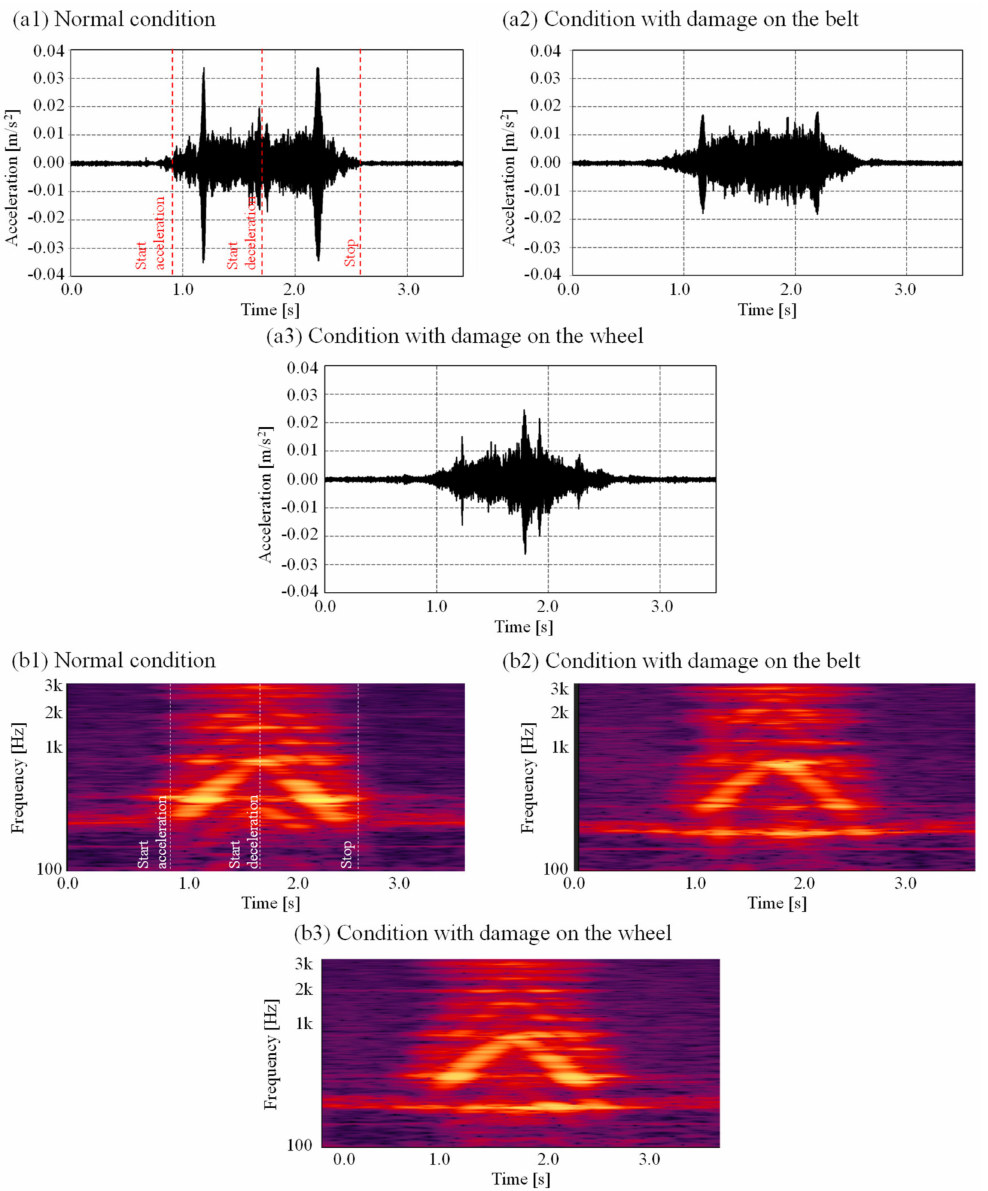
Figure 13. Acceleration waveforms and their spectrograms for the lifter ( a1,b1 ) operating in normal state, ( a2,b2 ) operating with a damaged belt, and ( a3,b3 ) operating with a damaged guide wheel. As shown in Figure 13( a1 ) and ( b1 ), the waveform starts to sweep up after around 0.9 s when the lifter starts to accelerate; after that, the waveform starts to sweep down after 1.8 s; then finally, the large fluctuation of the waveform finishes at around 2.8 s when the lifter